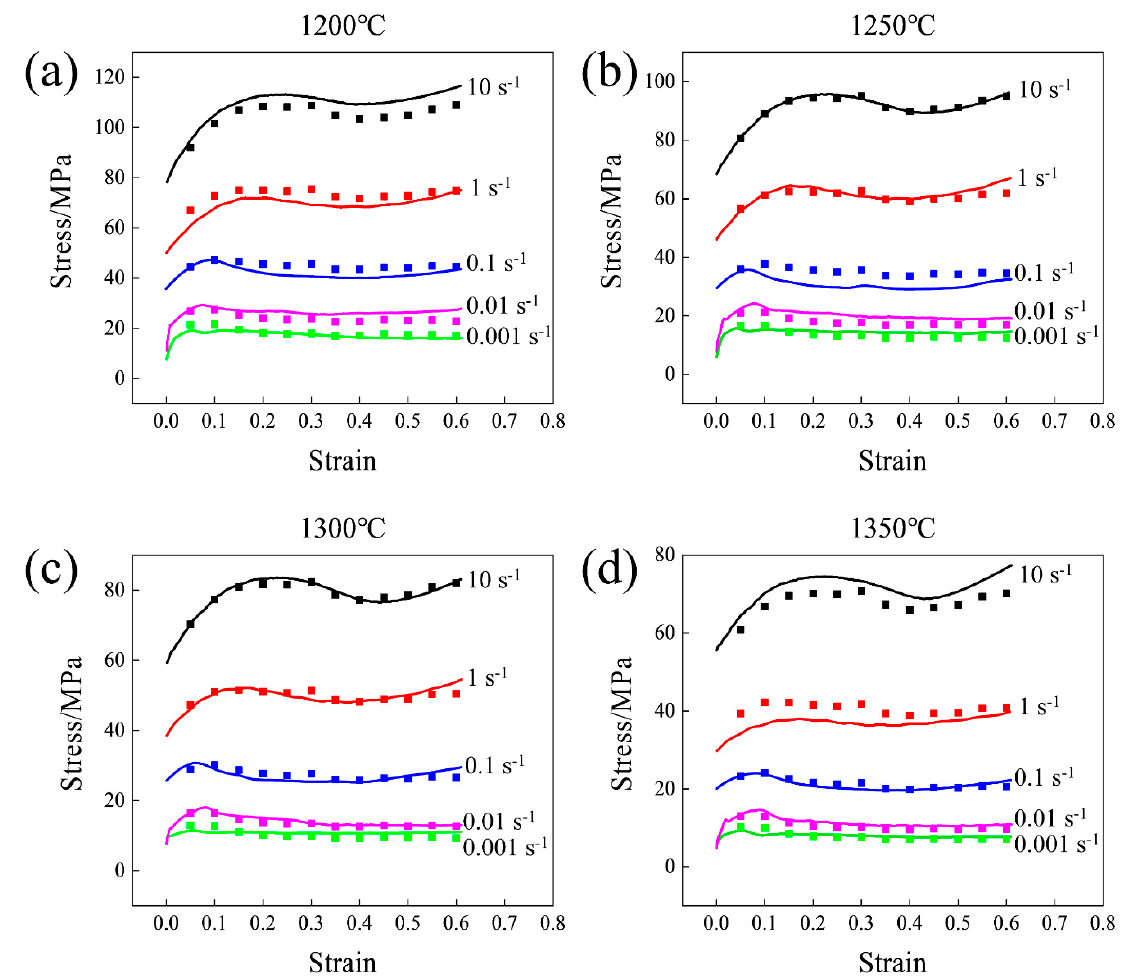
Figure 6. Predicted and experimental data of flow stress from Arrhenius model at various strain rates and temperatures: ( a ) 1200 °C ; ( b ) 1250 °C ; ( c ) 1300 °C ; ( d ) 1350 °C.